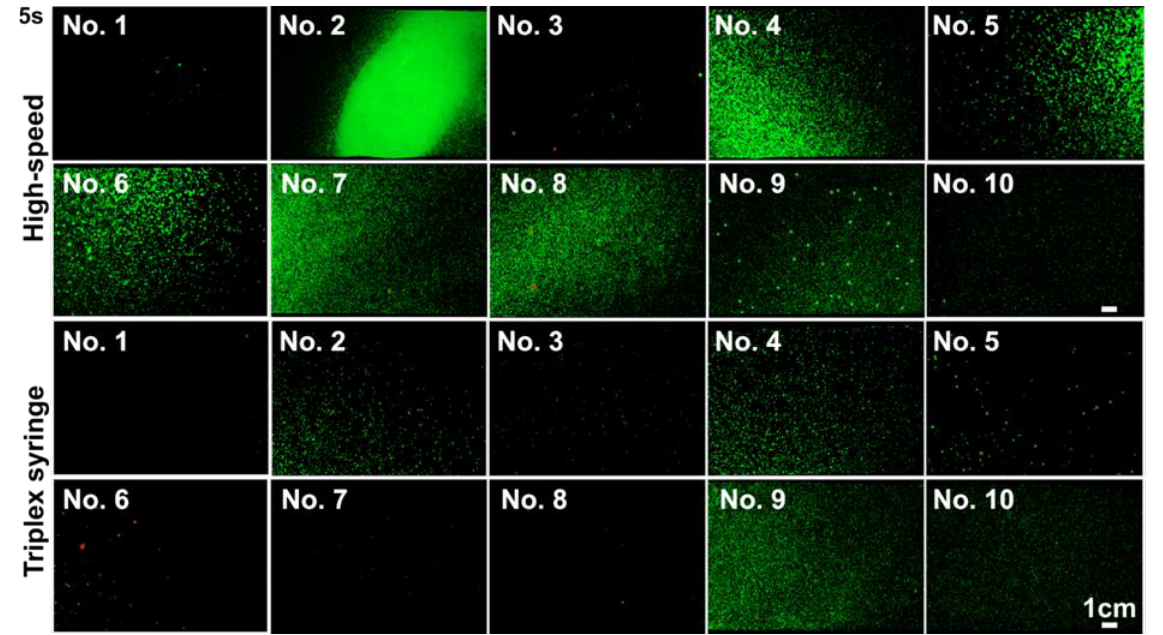
Figure 3. Splatter pattern by high-speed handpiece and triplex syringe after 5 s.